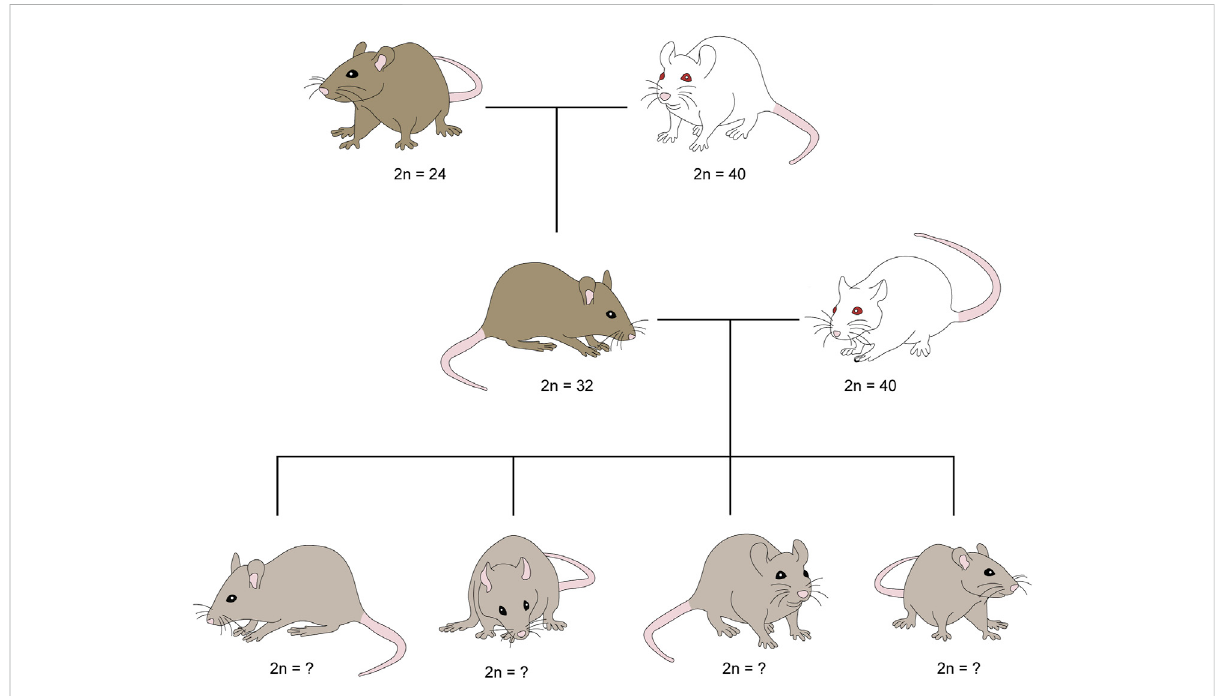
FIGURE 1 Origin ofthemice understudy that can inherit between 0and 8Rbchromosomes. Males and femalesof Robertsonian (Rb) heterozygotes 2n = 32 of Mus musculus domesticus were generated by crossing homozygotes Milano II race 2n = 24, with eight pairs of Rb metacentric chromosomes, and homozygote strain CD1 2n = 40, with all chromosomes telocentric. In turn, heterozygotes were crossed with homozygotes ( 2n = 40) to obtain offspring who could inherit between 0 and 8 Rb metacentric